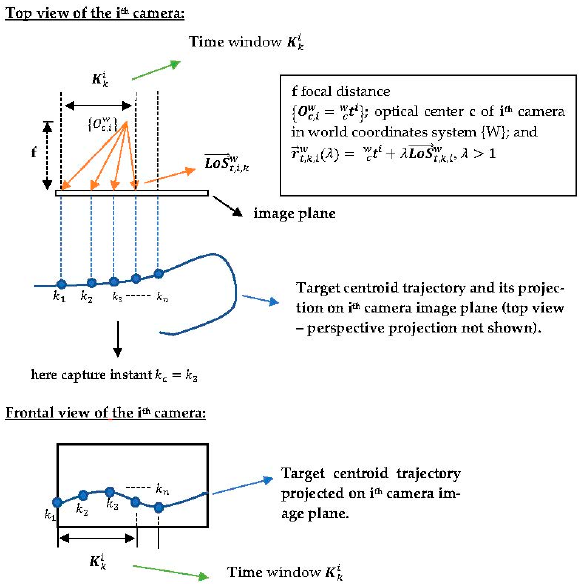
Figure 6. Top and front views of a detected target centroid trajectory within a time window K i An example of a target centroid trajectory in the image plane expressed in world coordinates {W} is depicted in Figure 7.